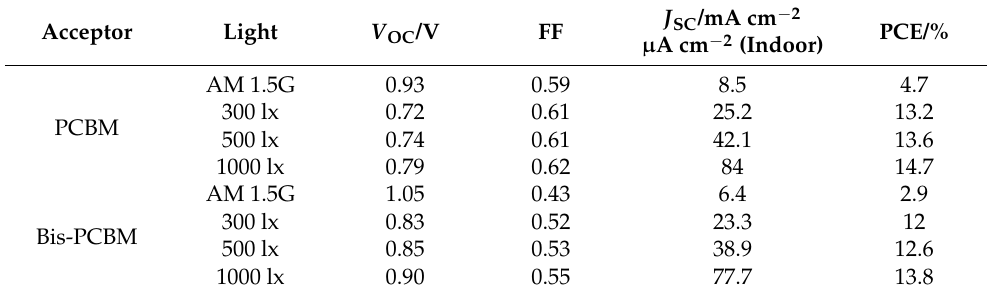
Table 1. The photovoltaic parameters of the OPV cells under different light sources with different light intensities. The J SC unit mA/cm 2 is for AM 1.5G, and µ A/cm 2 is for indoor light. J SC /mA cm − Acceptor Light V OC /V FF